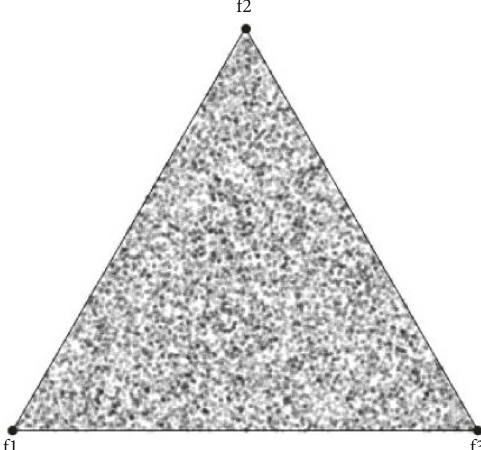
Figure 5: This is a test of our Dirichlet-based routine for random simplex-point picking, using a unit 2-simplex with 3 vertices, be- cause the uniformity associated with 10,000 points is easily illustrat- ed on a flat-screen ternary